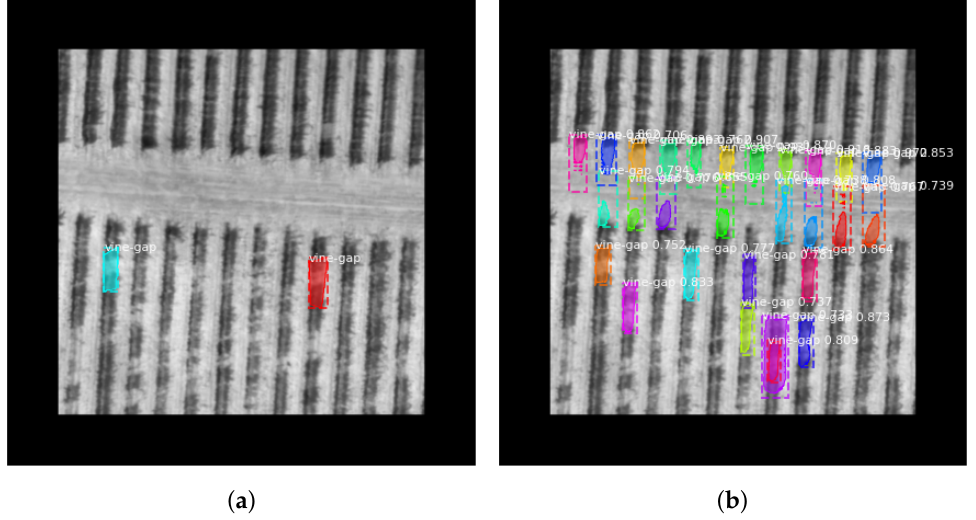
Figure 6. Examples of Mask-RCNN, after training ‘head’ layers for 30 epochs, miscategorizing the path. Dataset: GS; Weights: Tiny-YOLO; ( a ): Original; ( b ):